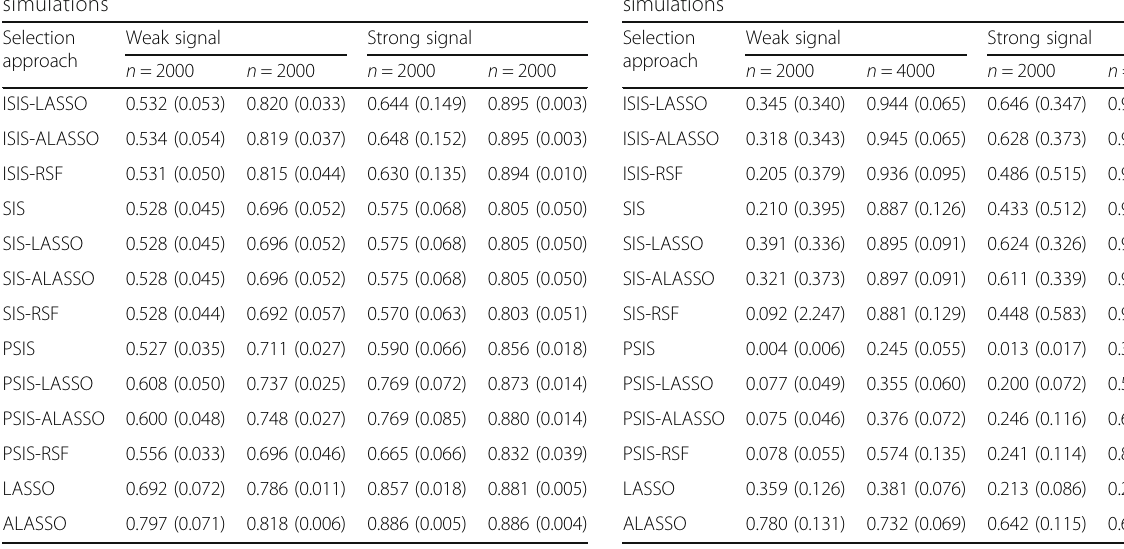
variables is assumed n = 300 (Fig. 3d).